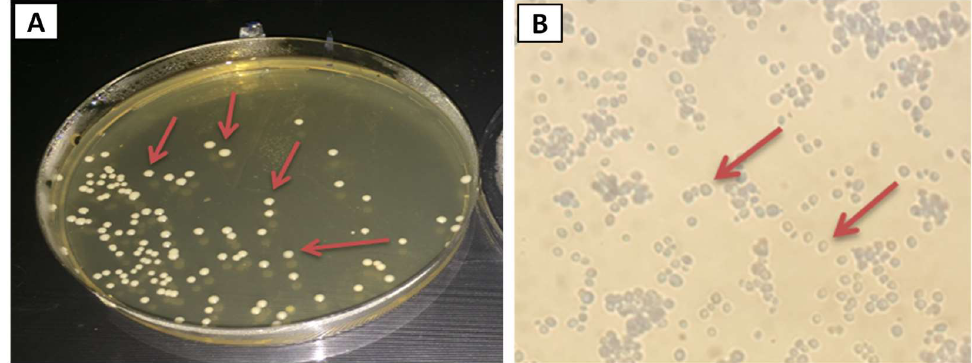
Figure 3. ( A ) Photographs of colonies of C. albicans on SDA and ( B ) optical microscopy image of candida, which appears as Gram-positive small oval or budding yeast cells.